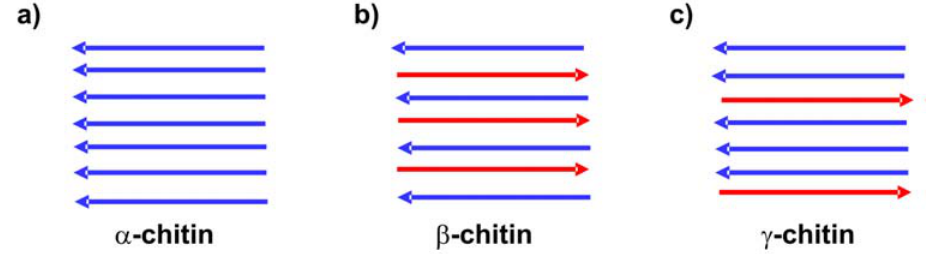
Figure 4. Schematic representation of the three polymorphic forms of chitin (a) α -chitin. (b) β -chitin. (c) γ